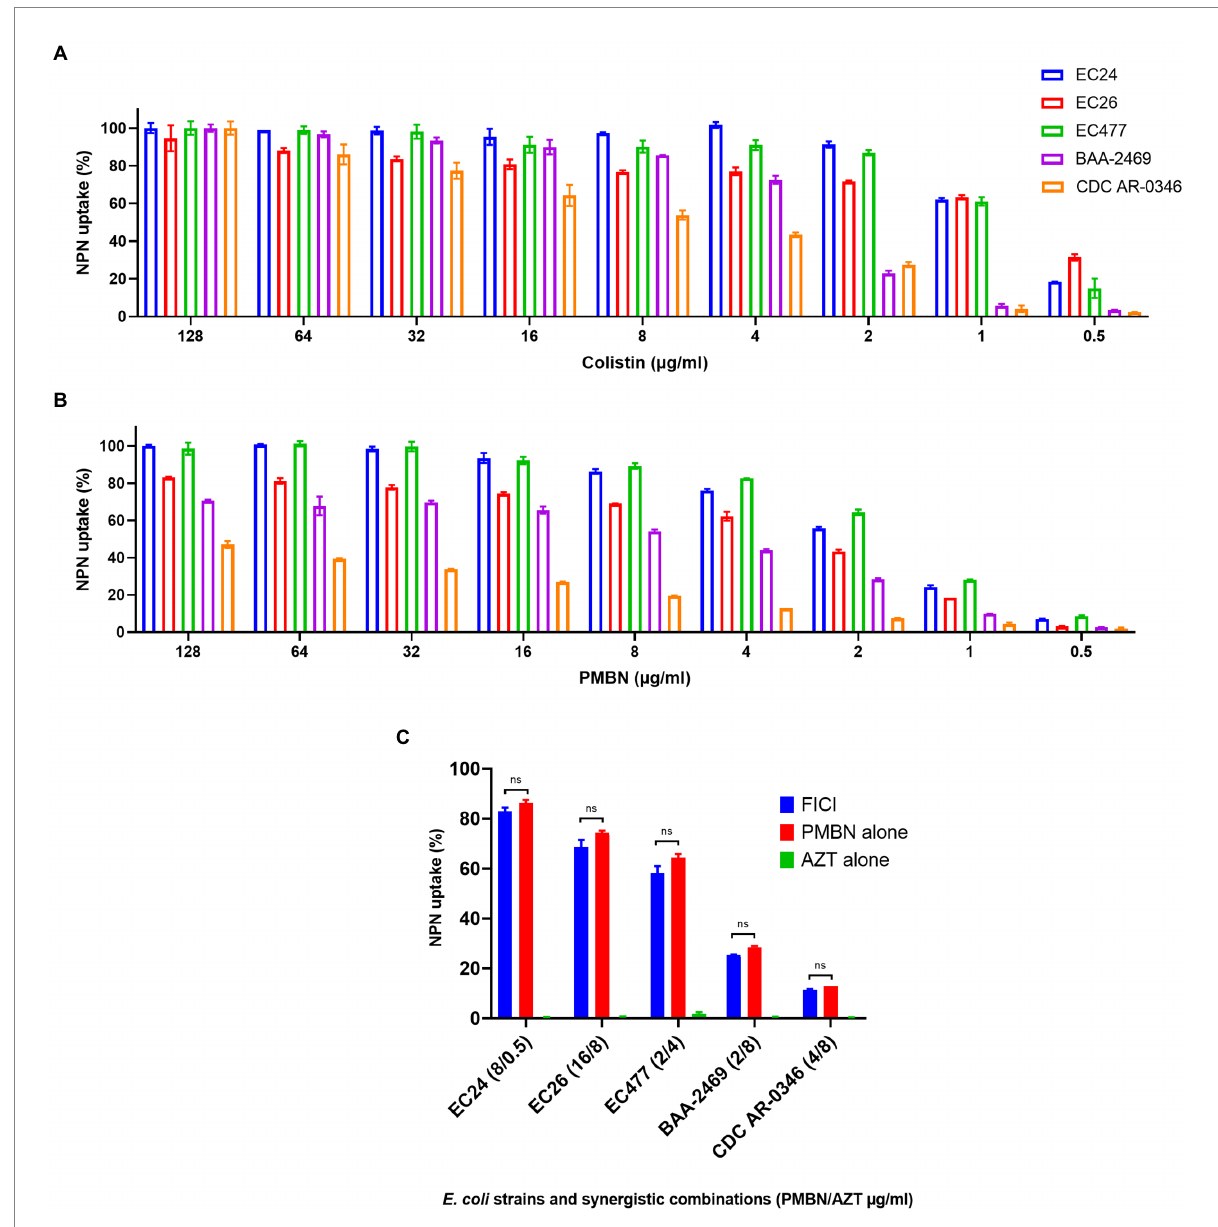
FIGURE 3 NPN uptake (%) of five selected E. coli strains. Data shown represent NPN uptake by bacteria treated with serial dilution (128–0.5 μ g/ml) of colistin used as a positive control (A) and PMBN (B) , in addition to bacteria treated with synergetic combination of PMBN and AZT at FICI compared to treatment with a single agent (C) . NS is